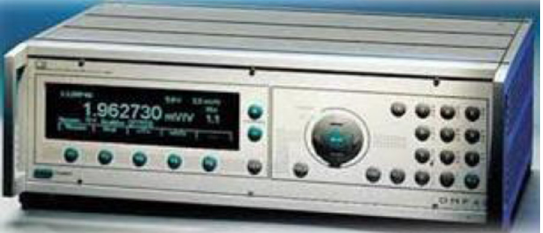
Fig. 3. DMP40 ampli fi er used in the experimental work.